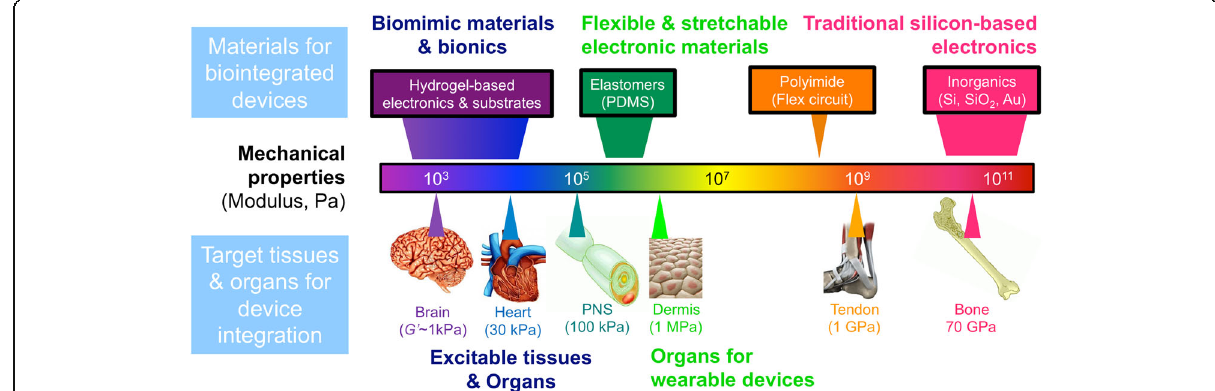
Fig. 3 Modulus matching can guide the design of flexible and biointegrated electronic devices. The mechanical properties of various classes of materials used in microfabricated electronic devices (top) and organs in the human body (bottom) are plotted on a logarithmic spectrum of mechanical modulus. Materials traditionally used in microelectronic device fabrication (e.g. silicon, oxides, and metals) exhibit Young ’ s moduli that are orders of magnitude larger than the excitable tissues with which they are intended to interface including the peripheral nervous system. There are opportunities to engineer PNI with stretchable and ultracompliant electrode materials that can better match the mechanical properties of the target